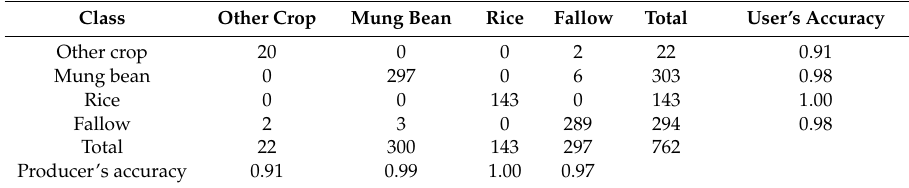
Table 4. Results of the segment based identification of the major crop types grown in the Barisal division in the period between February and April 2019.